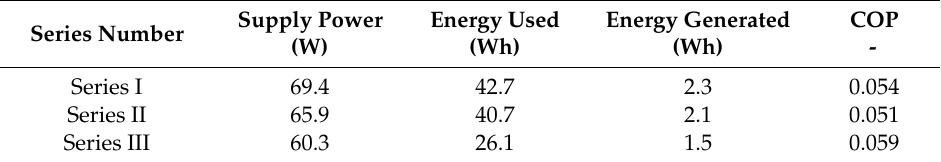
Table 3. Basic operation parameters and COP calculated for Stage